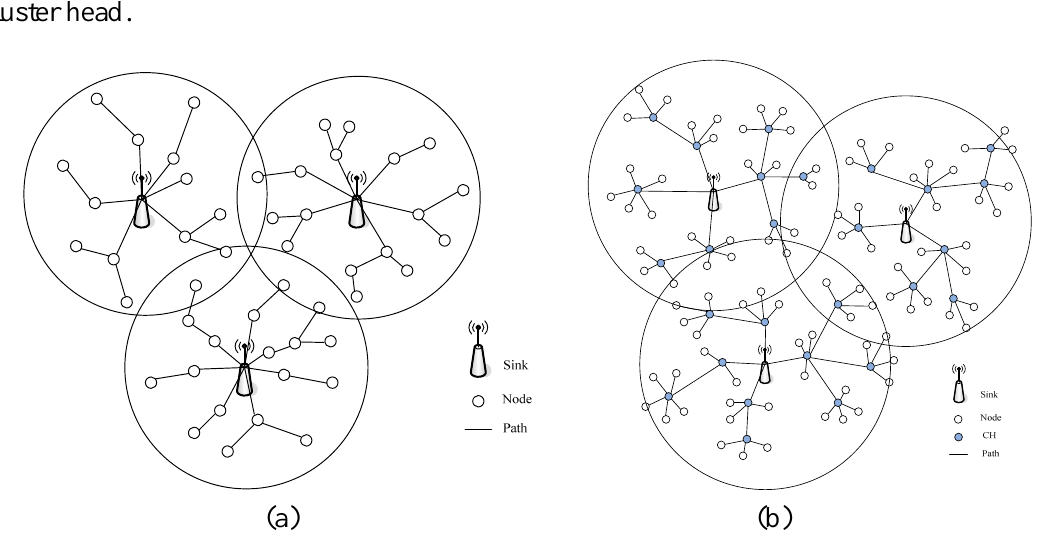
Figure 1. Sink-centric multiple sink cluster WSNs. (a) Sink as cluster head. (b) Non-sink as cluster